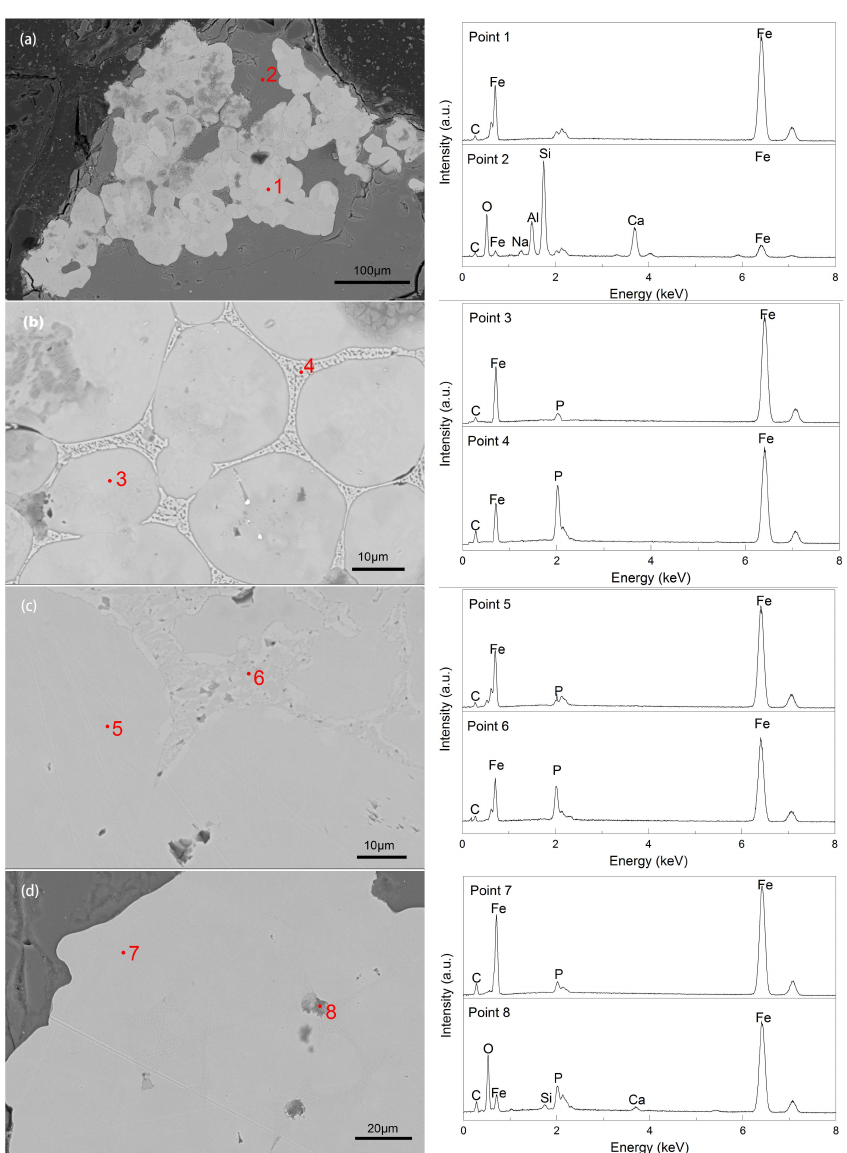
Figure 5. SEM-EDS results for the fusion process of boundaries in an accumulation iron particle group at 1548 K for different reduction times: ( a ) 20 min; ( b ) 30 min; ( c ) 40 min; ( d ) 50